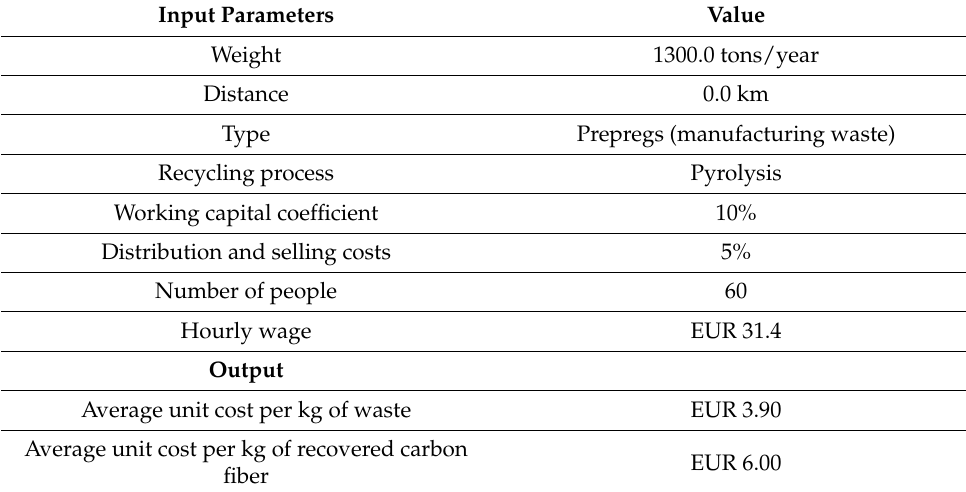
Table 7. Inputs and output provided from the developed